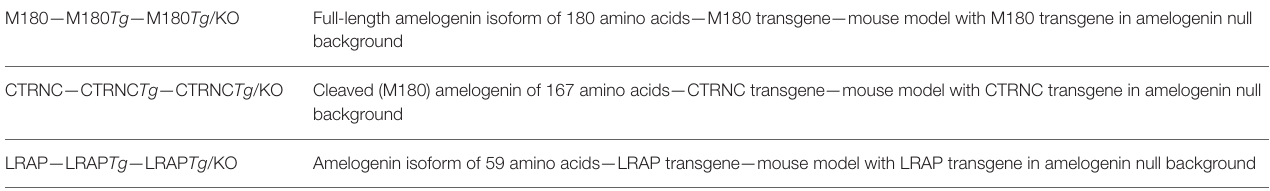
TABLE 1 | Abbreviations for amelogenin protein, transgenes, and mouse models.